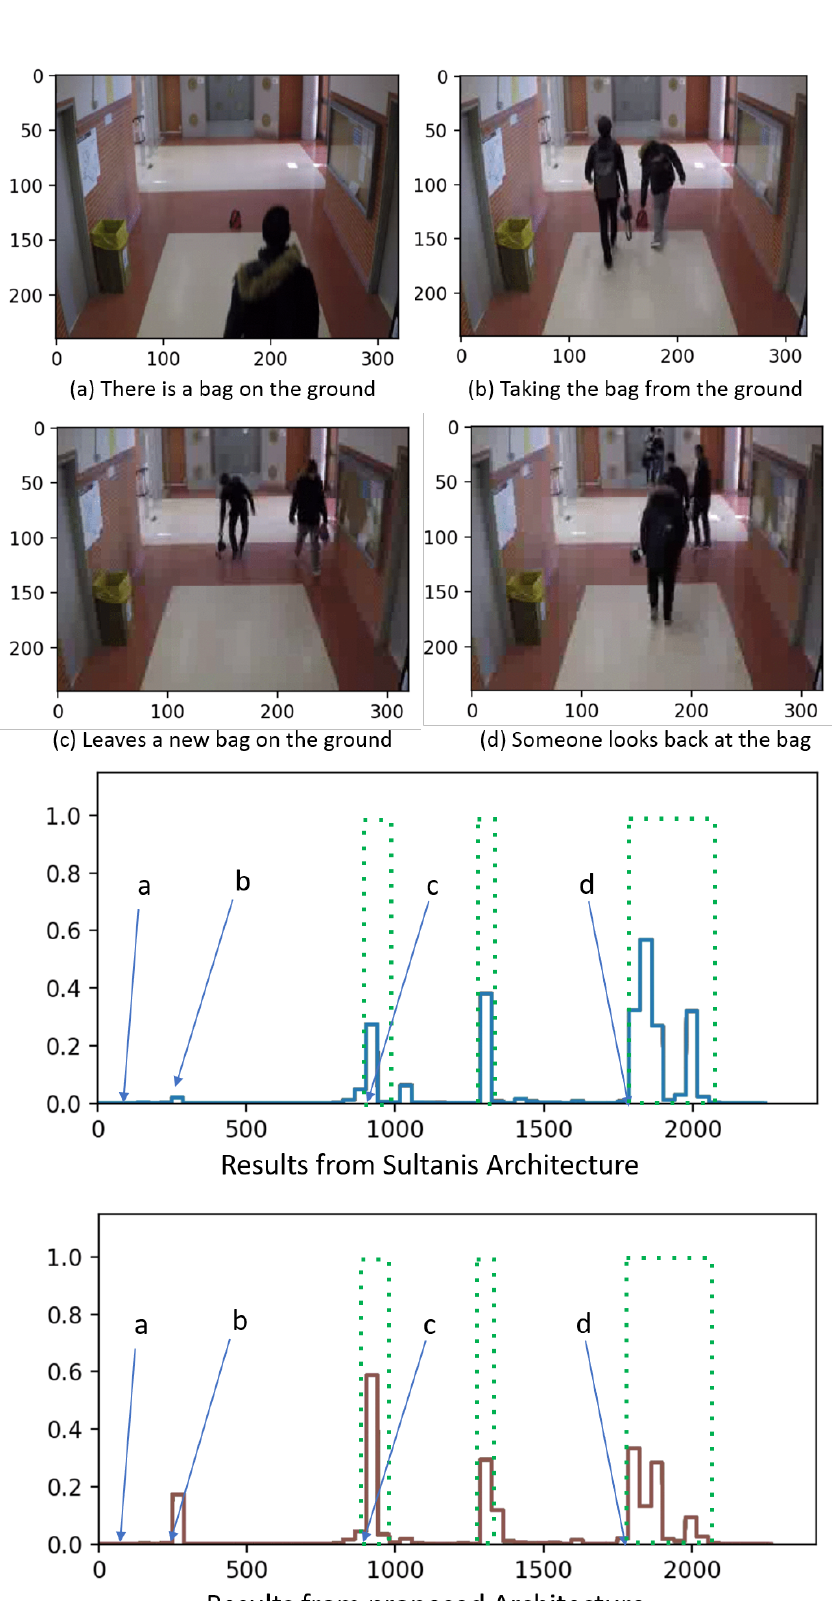
Figure 5. Qualitative visual results and comparison in scenes from